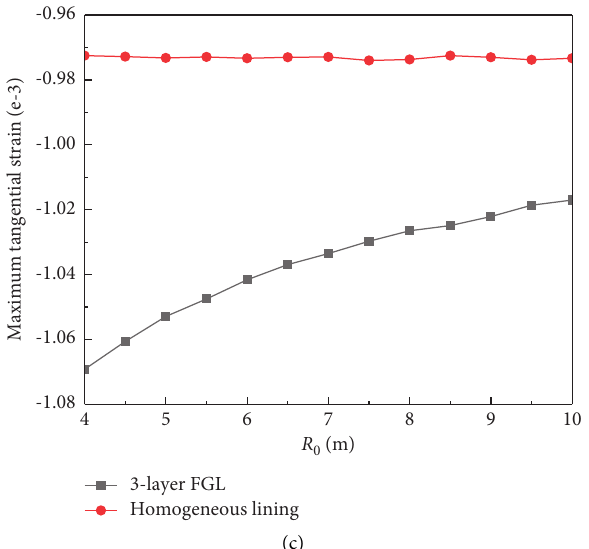
Figure 10: Variations in ultimate bearing capacity, maximum radial displacement, and maximum tangential strain with internal radius R (a) Ultimate bearing capacity. (b) Maximum radial displacement. (c) Maximum tangential